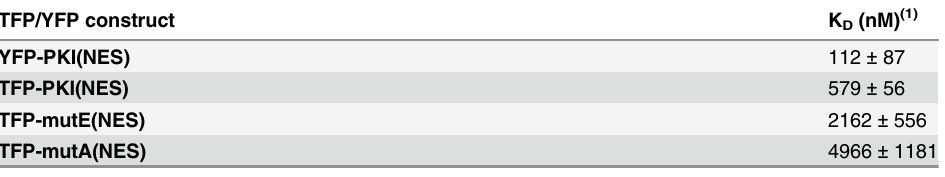
Table 1. Affinities (apparent K D ) of the different complexes studied, as estimated by fluorescence anisotropy titrations. TFP/YFP